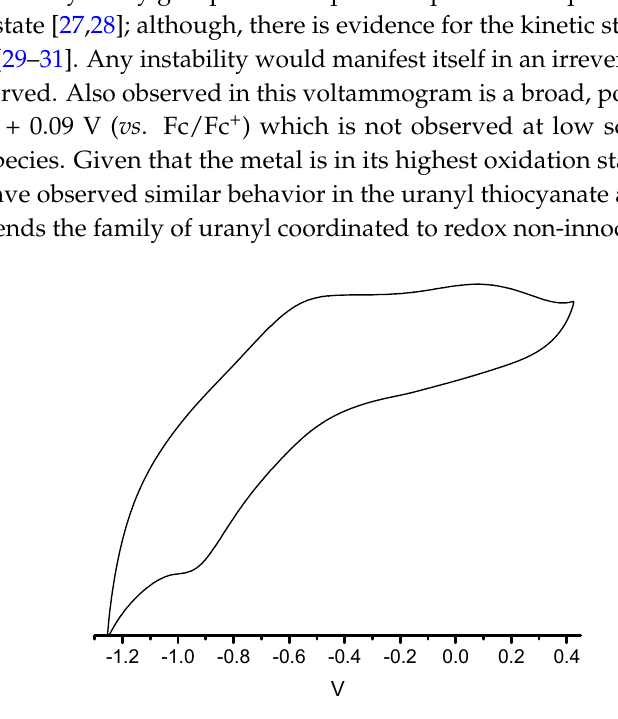
Figure 4. Cyclic Voltammogram of [ 1 ] vs . Fc/Fc + in MeCN at 293 K, with 0.1 M [Bu 4 N][BPh 4 ] as a supporting electrolyte (scan rate = 0.1 V·s − 1 ).